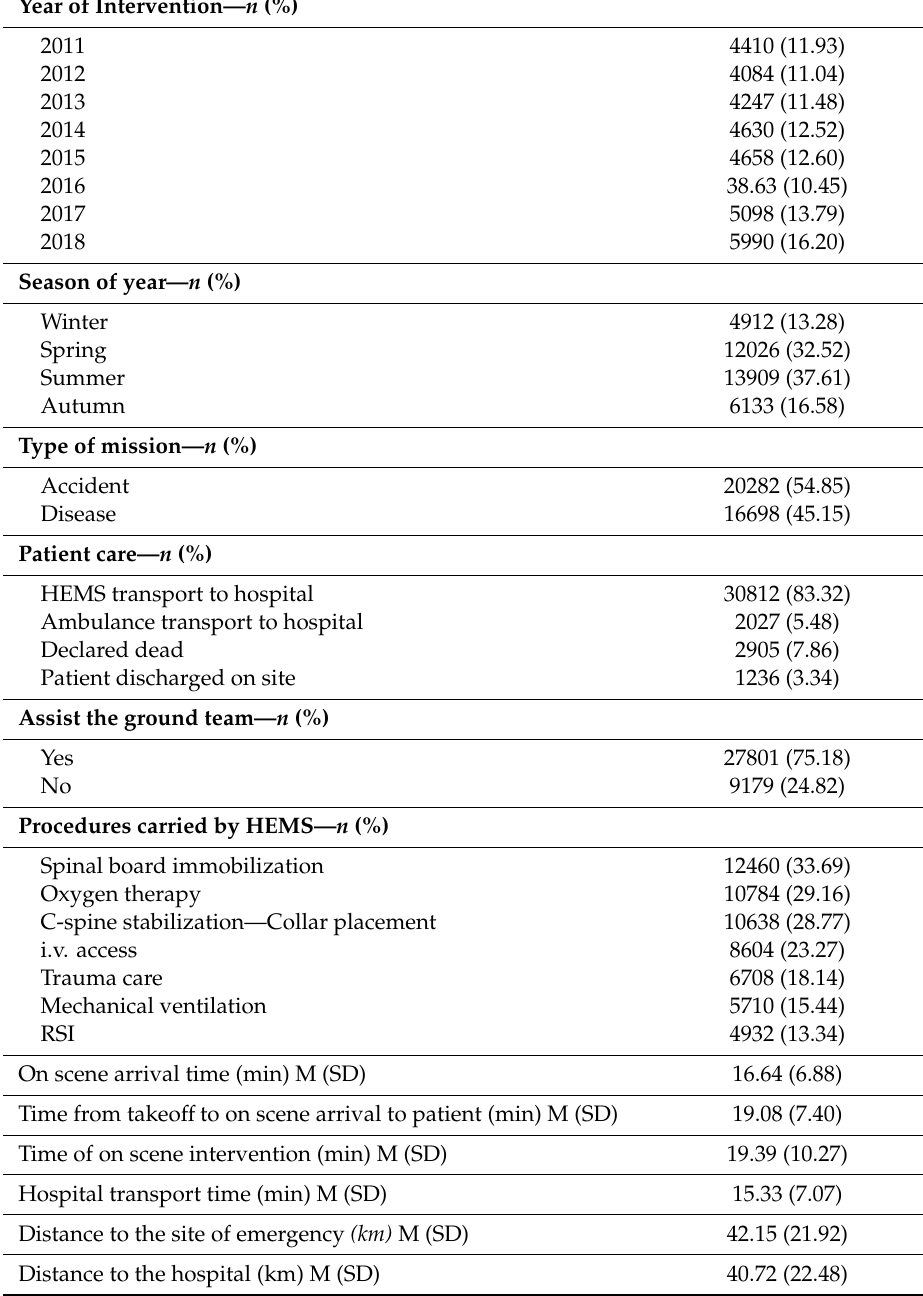
Table 2. Helicopter Emergency Medical Service (HEMS) Mission